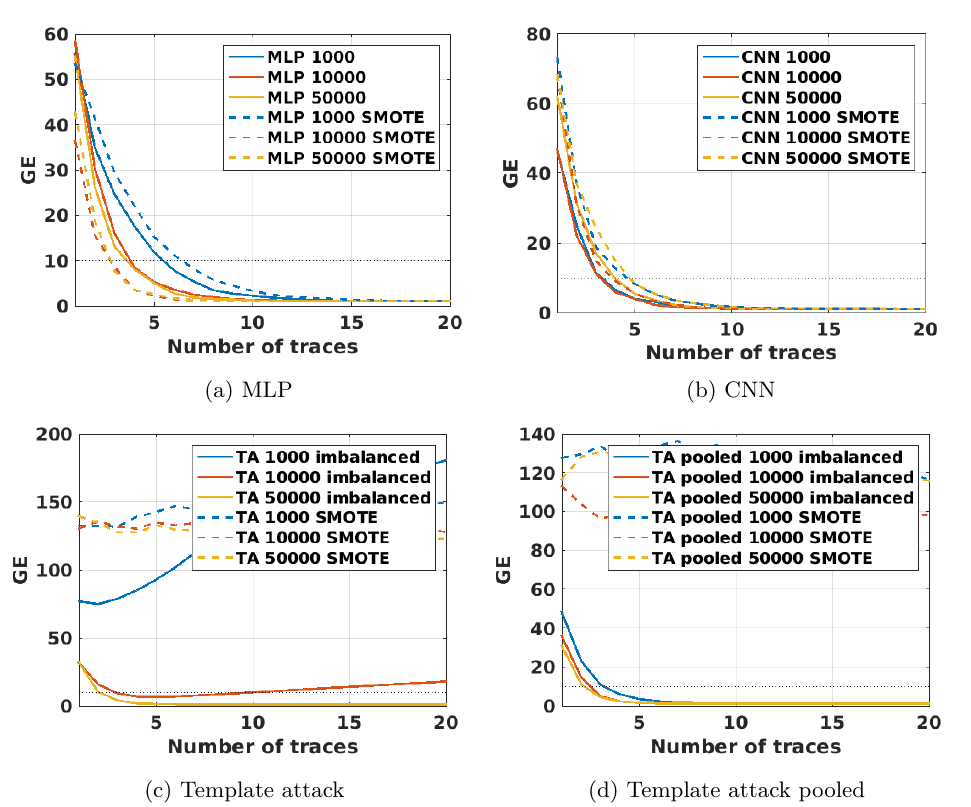
Figure 5: Guessing entropy for imbalanced and SMOTE on DPAcontest v4, deep learning and template attack